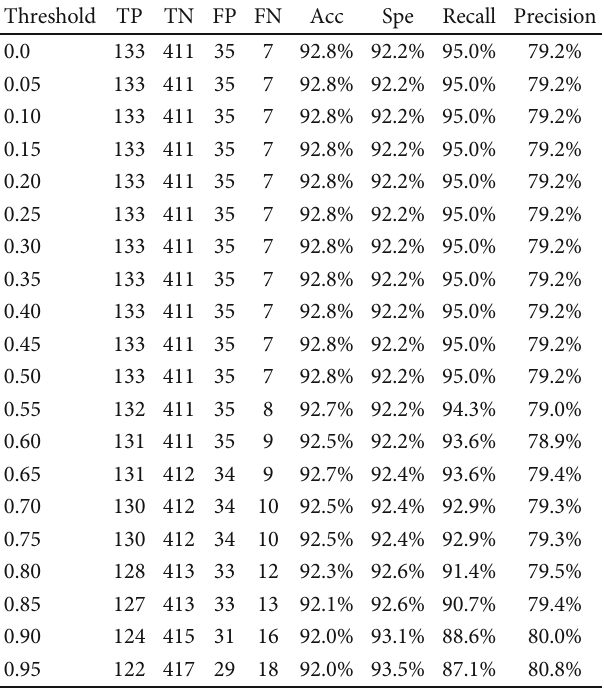
Table 4: Comparison of evaluation index results under di ff erent con fi dence